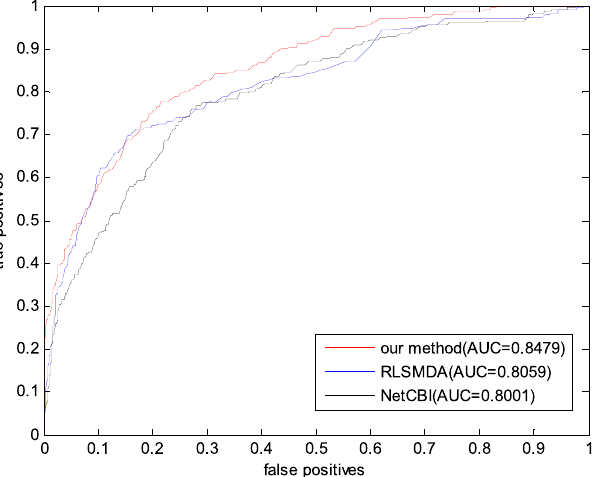
Figure 3. The ROC curves and AUC values of RLSMDA, NetCBI and our method(GSTRW).